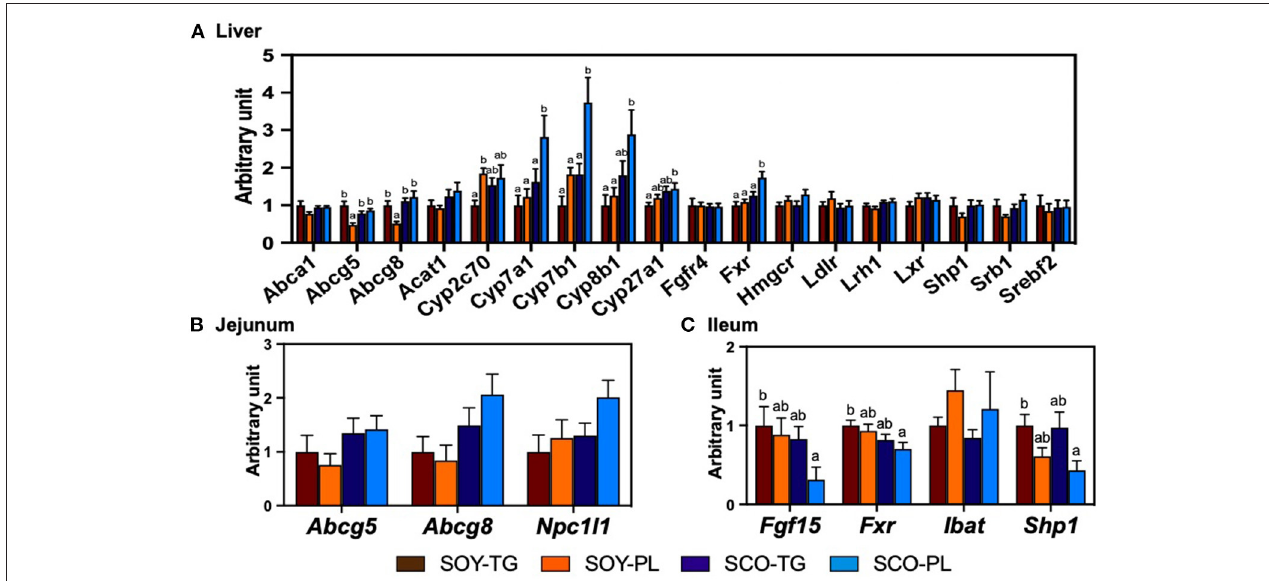
FIGURE 2 | The mRNA expression levels of genes involved in cholesterol metabolism in the liver (A) and the mucosa of jejunum (B) and ileum (C) . Data represent the mean ± SEM ( n = 8). Different letters indicate significantly different at p < 0.05 (Tukey’s multiple comparison test). The mRNA expression levels were determined using the glyceraldehyde 3-phosphate dehydrogenase ( Gapdh ) expression levels for normalization. The mRNA expression levels of genes are shown relative to those determined from the livers of mice in the control group (set at 1). The abbreviation names of these genes are listed in Supplementary Table 2 . SCO-PL, scallop oil’s phospholipids fraction; SCO-TG, scallop oil’s triglyceride fraction; SOY-PL, soybean oil’s phospholipids fraction; SOY-TG, soybean oil.